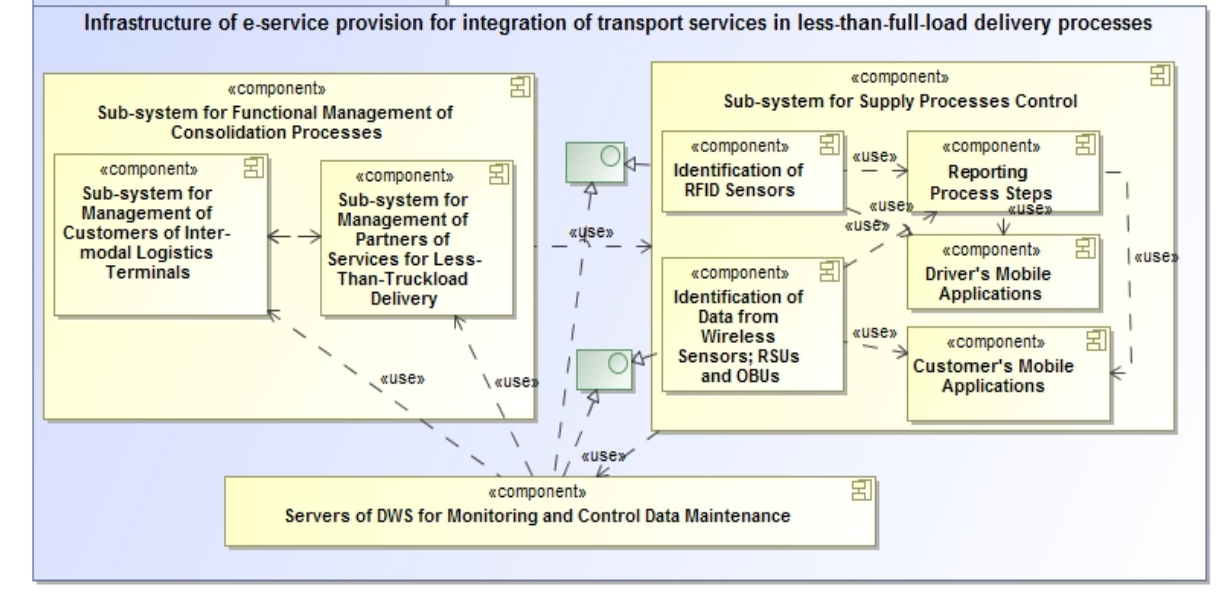
Figure 4. A conceptual model for assessment of transport services in the e-STMS for less-than-truck- load delivery process